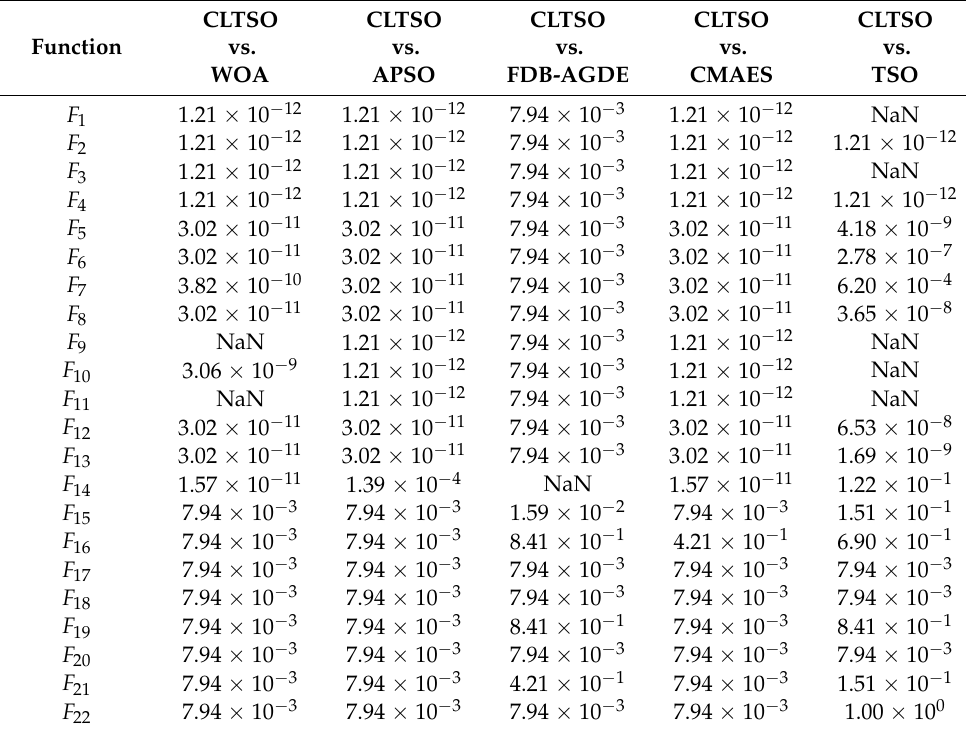
Table 8. Results of Wilcoxon test.